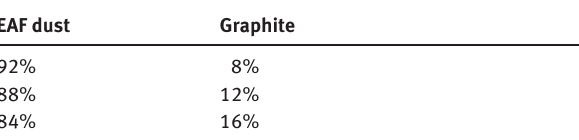
Table 3: The ratio of the dust to graphite in mixture